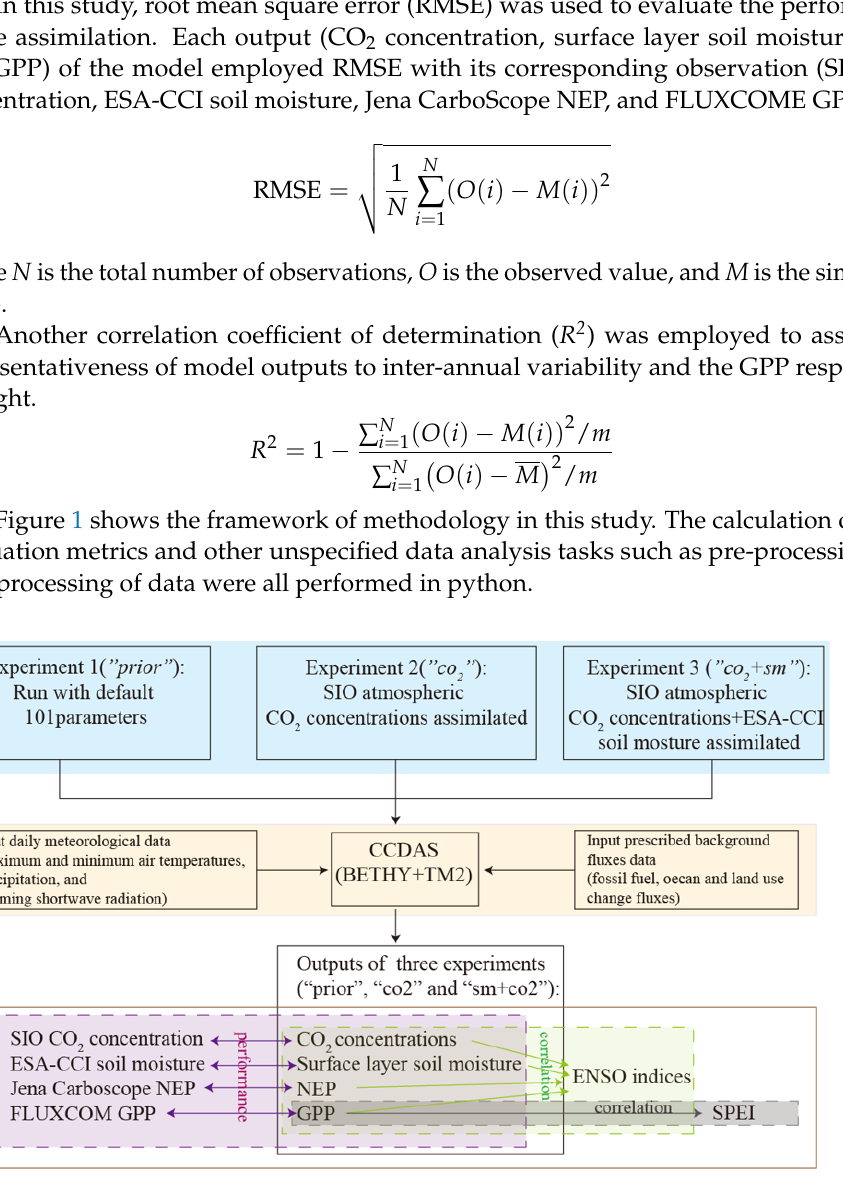
Figure 1. The methodology framework of this study. The blue-shaded part denotes the setup of three experiments adopted in CCDAS. The orange-shaded part denotes the CCDAS and its inputs. The purple-shaded part denotes the validation of assimilation performance compared with the SIO observations, ESA-CCI observations, Jena CarboScope NEP, and FLUXCOM GPP with simulated CO 2 concentrations, surface layer soil moisture, NEP, and GPP, respectively. The inter-annual variability representation of model through calculating the correlation of simulated variables with ENSO indices (green). The gray-shaded part denotes the relationship of GPP and SPEI to reflect the response of GPP to